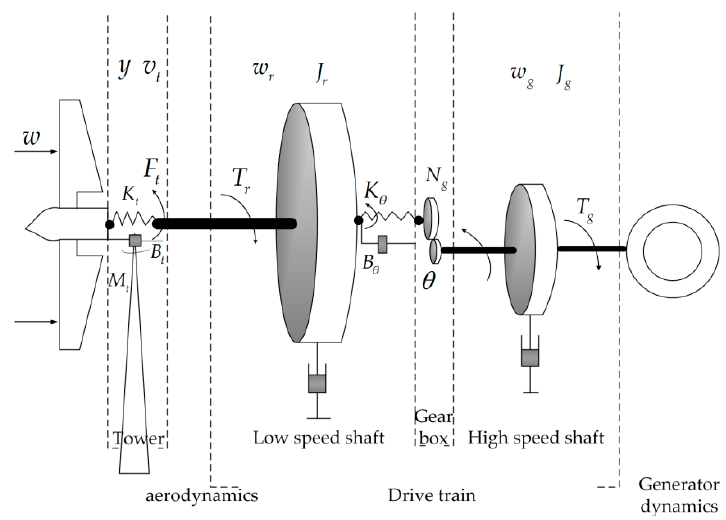
Figure 2. The mechanical structure of the VSWT generation system.